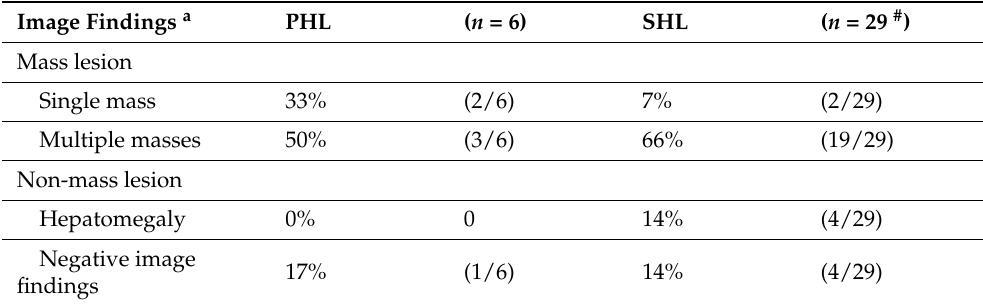
Table 3. Radiographic presentation in both